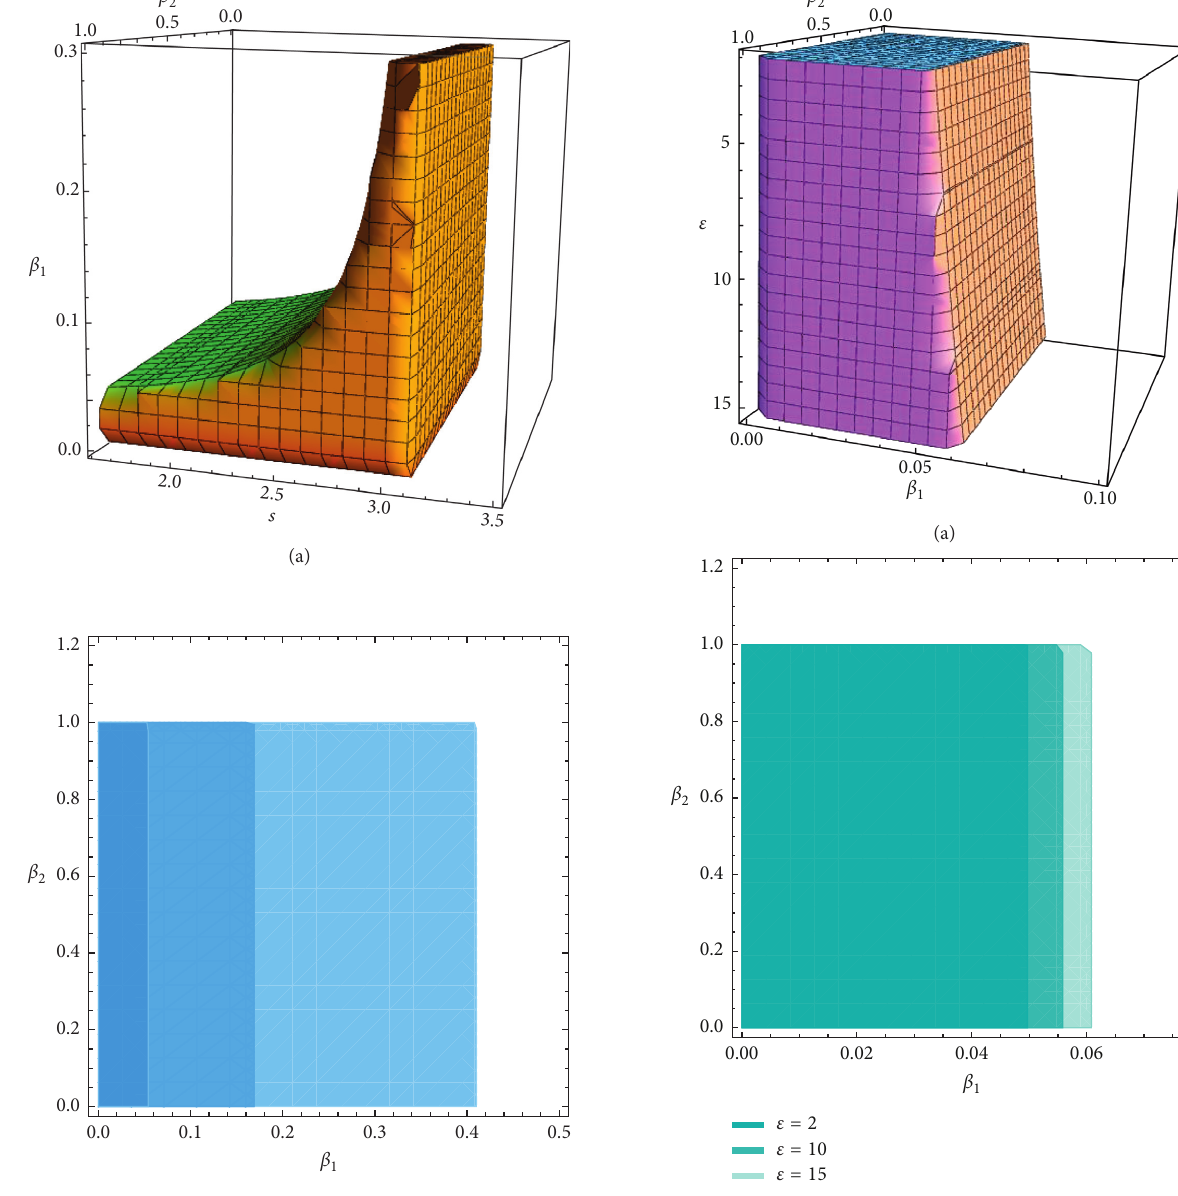
, β , and ε . (a) 3D stable 1 2 , β ) plane. 1 2